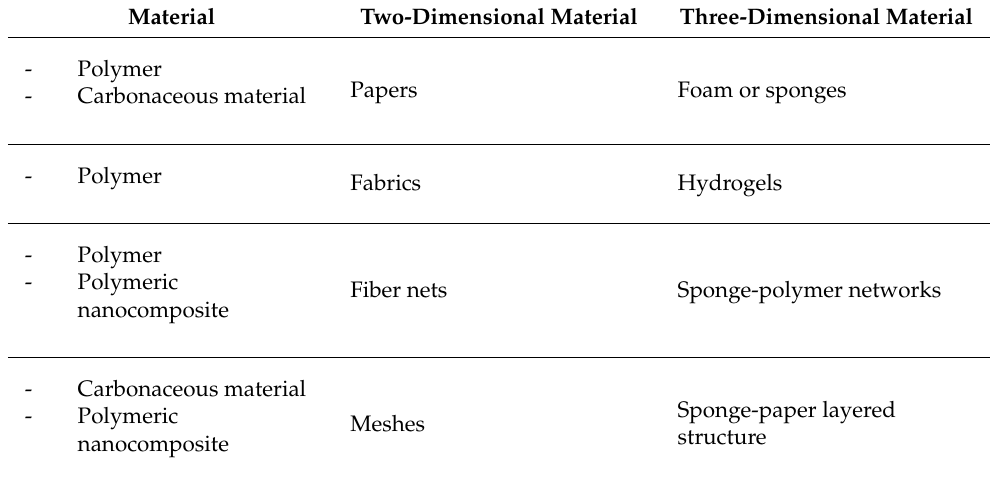
Table 3. General materials for filtration media for